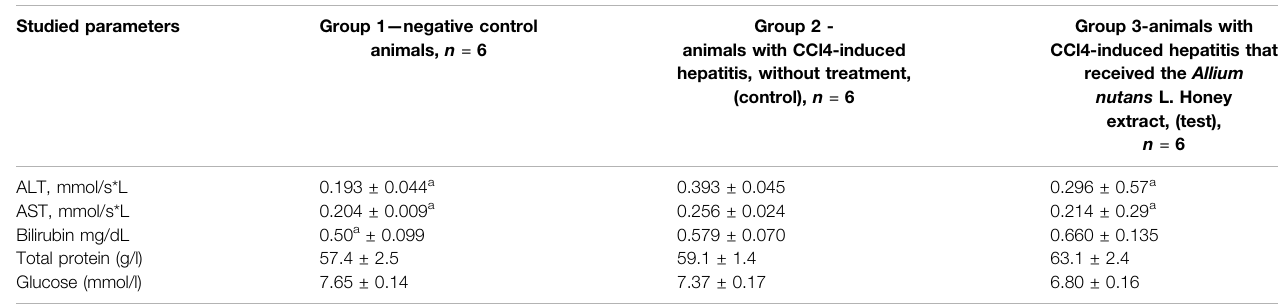
TABLE 6 | The effect of the Allium nutans L. honey extract on biochemical parameters. hepatitis ( n (cid:2) 6). Studied